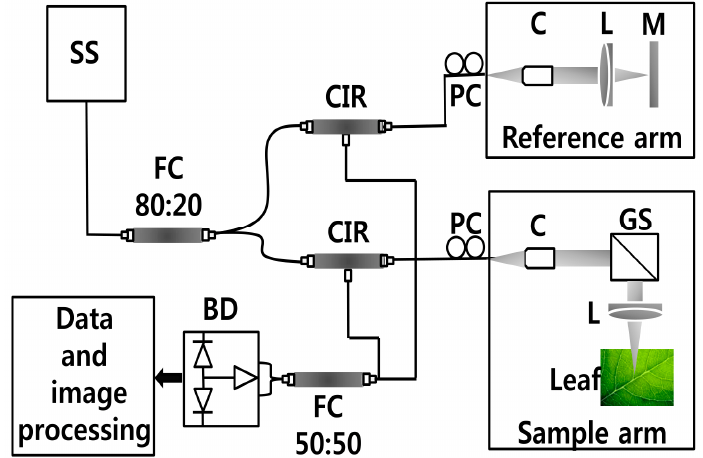
Figure 1. SS-OCT system configuration. Abbreviations: BD—balanced detector, C—collimator, CIR—circulator, FC—fiber coupler, GS—galvano-scanner, L—lens, M—mirror, PC—polarization controller, SS—swept source laser 1310 nm.